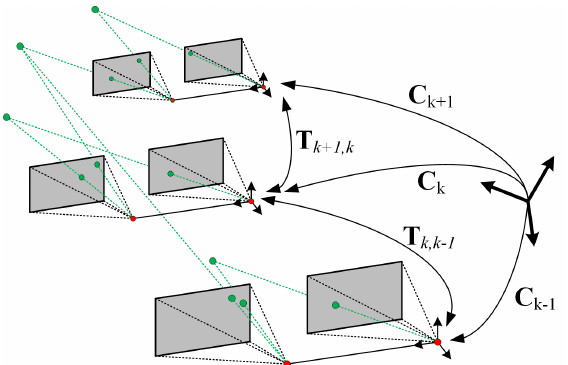
Figure 2: Stereo Visual SLAM process